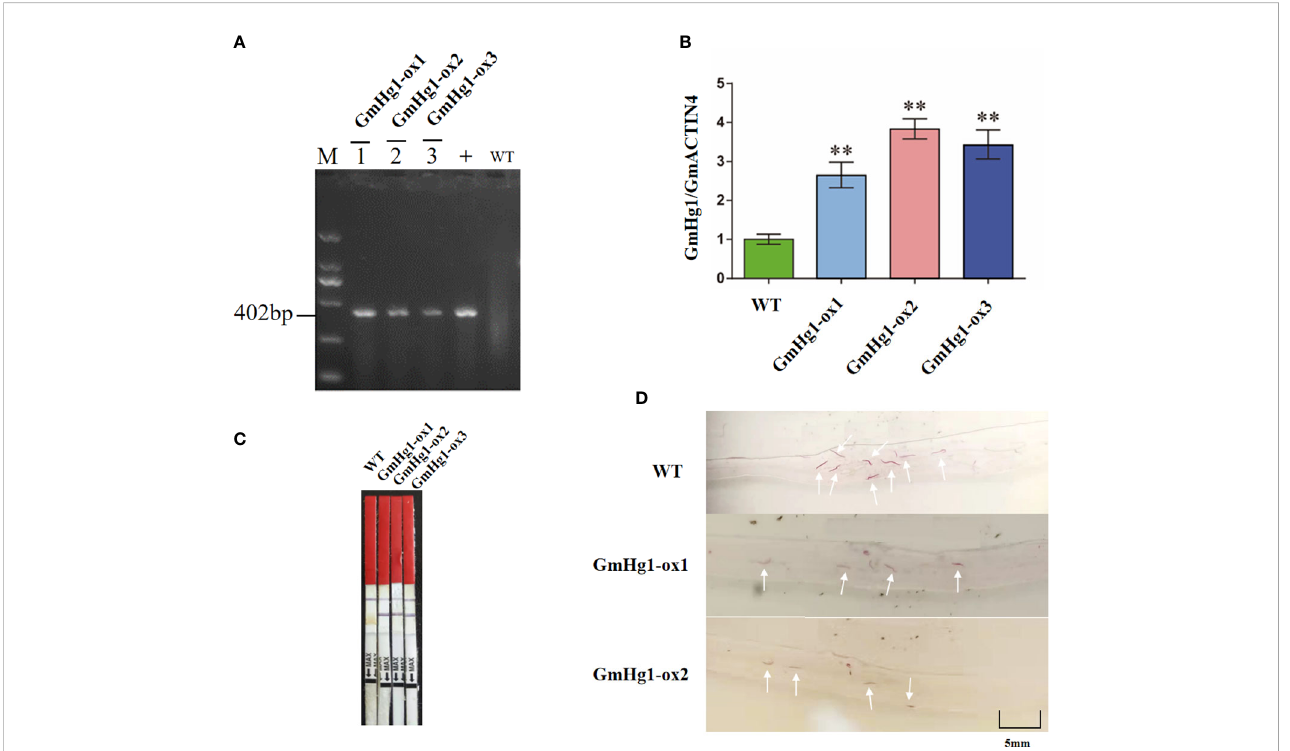
FIGURE 8 Identi fi cation of GmHg1-OX transgenic soybeans. (A) Gel image of PCR products obtained with primer sets for Bar gene regions of the vector. M: DL2000 marker. 1 – 3: transgenic soybeans; WT: DNA of wild-type soybean plants. +: Plasmid of the pCAMBIA 3300 - GmHg1 vector. (B) GmHg1 gene expression level in transgenic and WT soybean by qRT-PCR. GmACTIN4 was used as an internal reference gene. Asterisks indicate a signi fi cant difference compared with the corresponding controls (Student ’ s t -test: ** p < 0.01). Values represent the means of three biological replicates. (C) Detection of the